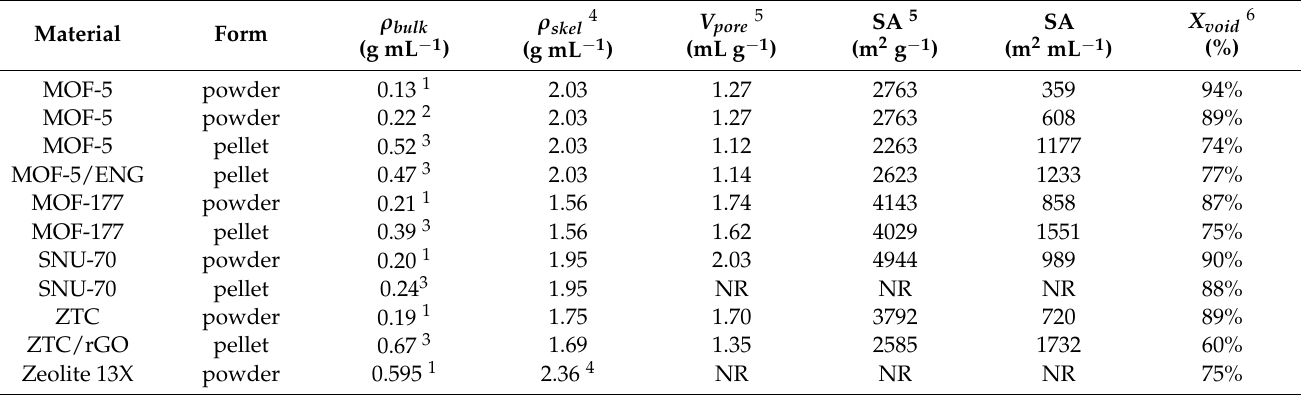
Figure 3. Structural trends across select porous carbons, zeolites, and MOFs. ( a ) Gravimetric BET surface area, ( b ) volumetric BET surface area, and ( c ) void fraction, X void , as a function of bulk density for ideal single crystals ( • ), laboratory powders ( ✱ ), and laboratory-densified materials (×). Select zeolites shown in yellow, MOFs in orange, MOF-5 in red, MOF-177 in blue, ZTC in black, and expanded/compressed ZTCs in green. The lines in ( a , b ) correspond to an exponential fit to all crystalline materials. The lines in ( c ) correspond to constant skeletal densities: 1.56 (blue), 2.10 (grey), and 3.04 (turquoise) g mL −1 . See Section S3 in the Supplementary Materials. Table 2. Structural properties of selected MOFs, porous carbons, and zeolites (a more complete list is shown in Tables S4 and